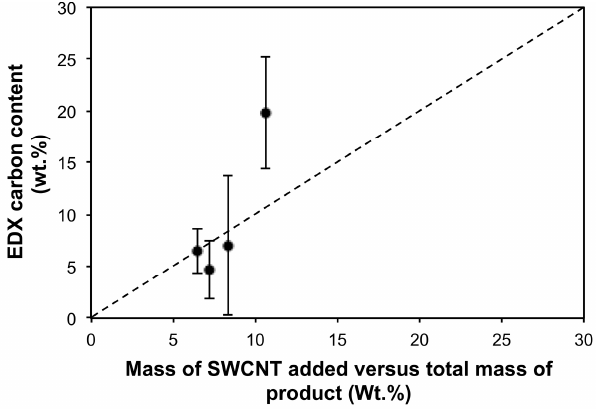
Figure 5. Carbon content (wt.%) as determined by EDX as a function of the calculated ideal values of SWCNTs (wt.%) based on the mass of SWCNT added to the electroless reaction mixtures, as a function of the final mass of the air-dried products from the reactions. The dashed line represents an ideal relationship assuming both a homogeneous material and that all the SWCNTs are incorporated into the composite.